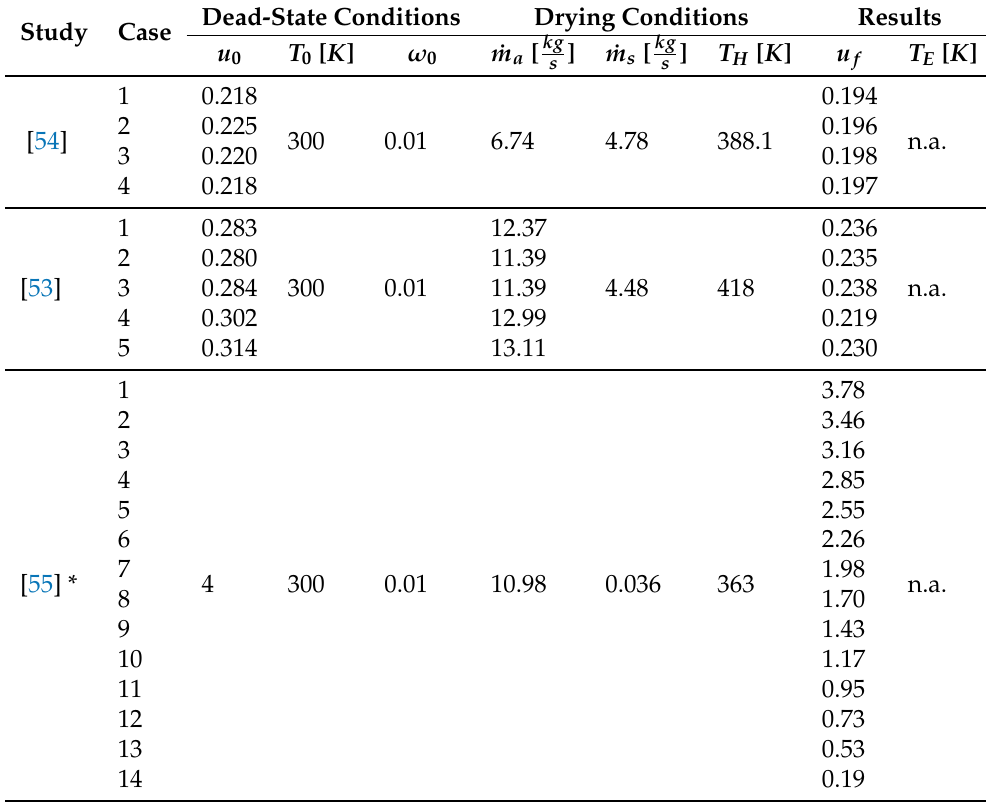
Table A4. The validation cases on off-design conditions; (*) we reconstruct the experimental drying curve measured at u 0 =